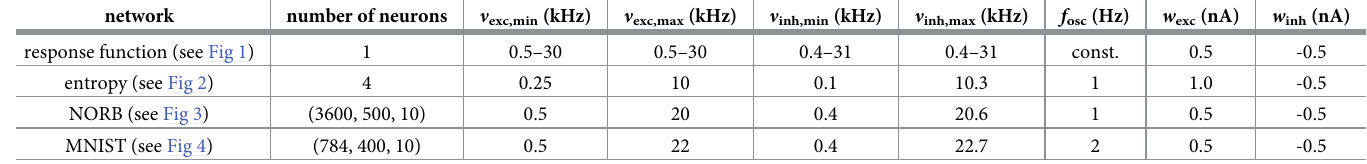
Table 2. Hierarchical network parameters. network